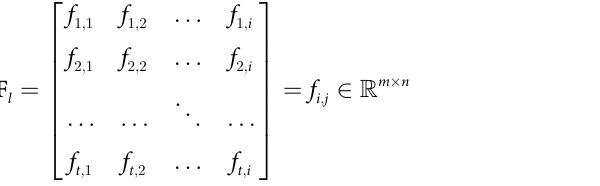
( i = 1–5): finger and thumb proximal interphalangeal joints, D i